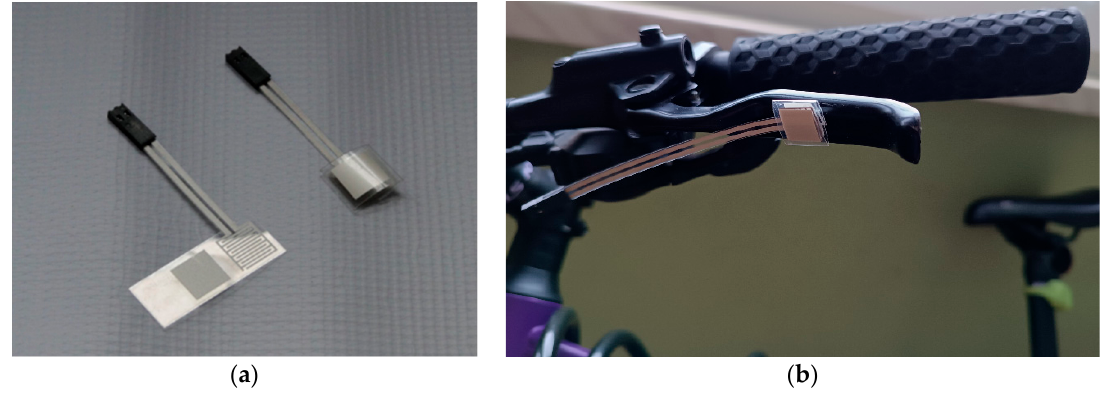
Figure 3. Folic tactile sensor ( a ) placed on the brake handle of the bike ( b ), patent PL 222119.B1 (author’s material).